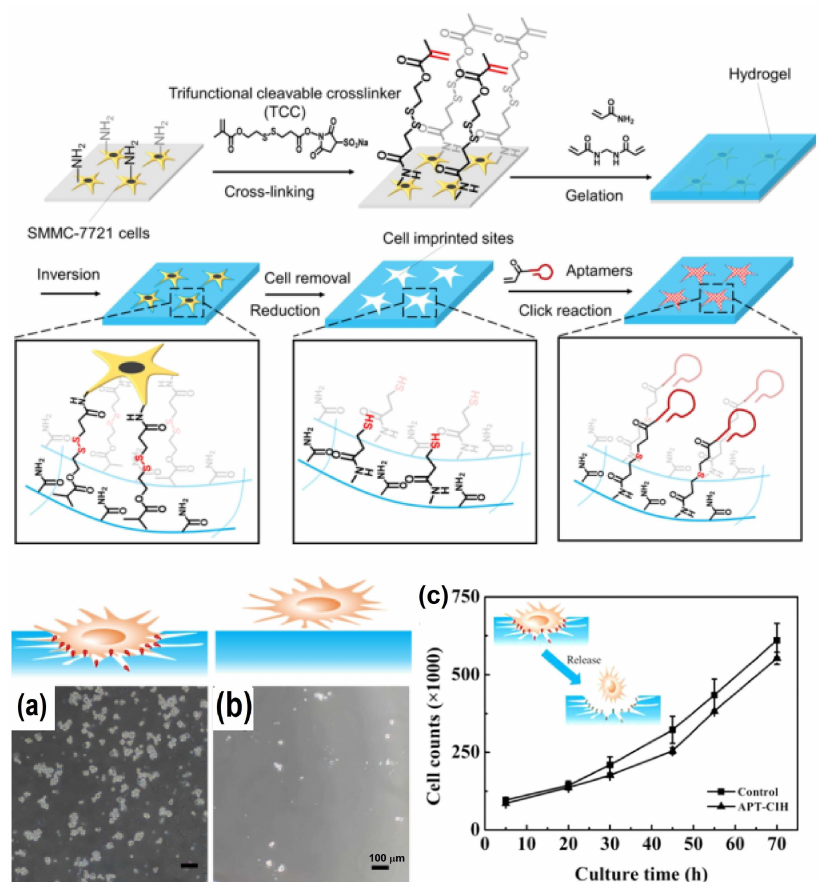
Figure 5. Preparation of cell-imprinted hydrogel for CTCs capture. ( a , b ) SMMC-7721 cells on APT- CIH and NIH, respectively. ( c ) Proliferation curve of SMMC-7721 cells released from APT-CIH and untreated control. Reproduced with permission from